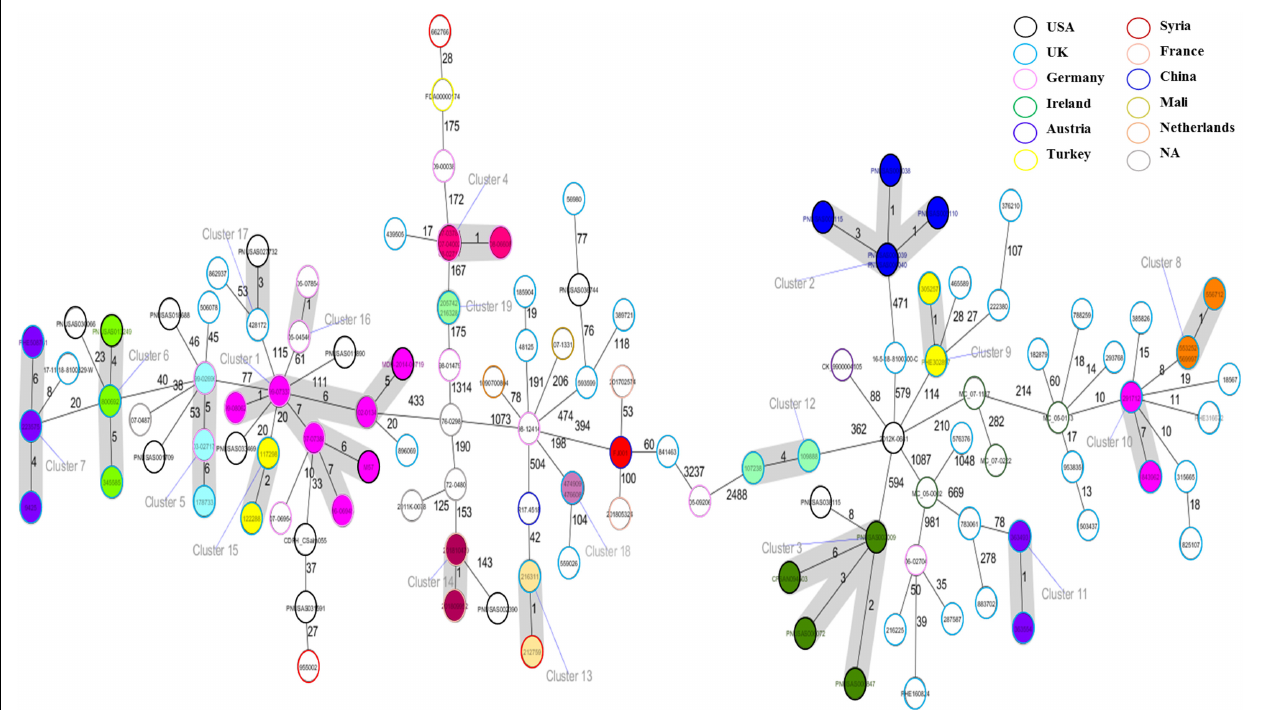
FIGURE 4 | Minimum spanning tree of 121 Salmonella Telelkebir isolates from different origins are depicted here. The numbers on the connecting lines illustrate the numbers of different alleles between connected samples. Closely related samples are represented with shaded circles of closely related genotypes ( ≤ 7 different cgMLST alleles) are shaded with gray. The FJ001 strain is shaded in